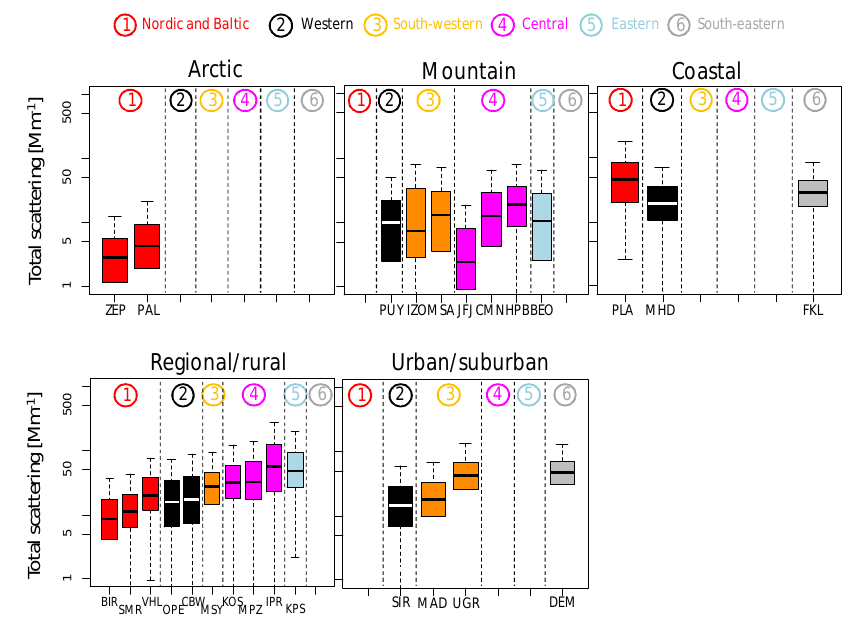
Figure 2. Total aerosol scattering coefficients in the green divided by station setting. Different colours highlight different geographical locations. At SIR, aerosol scattering was available only at 450nm. Medians (horizontal lines in the boxes), percentiles 25 and 75 (lower and upper limits of the boxes) and percentiles 5 and 95 (lower and upper limits of the vertical dashed lines) are reported. Hourly data were used for the